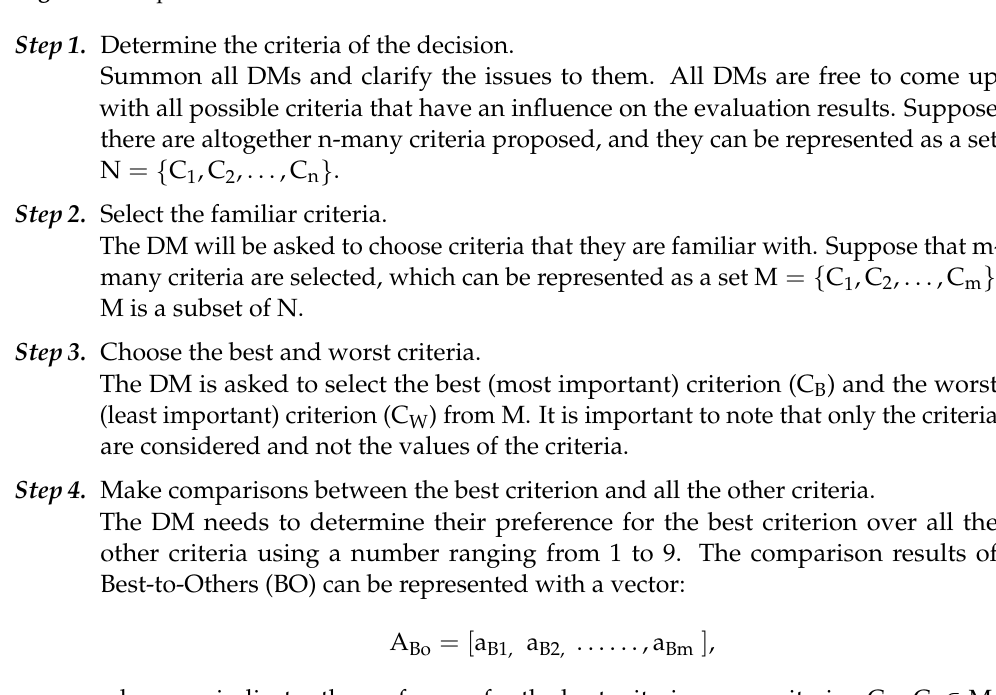
Figure 1. The process of